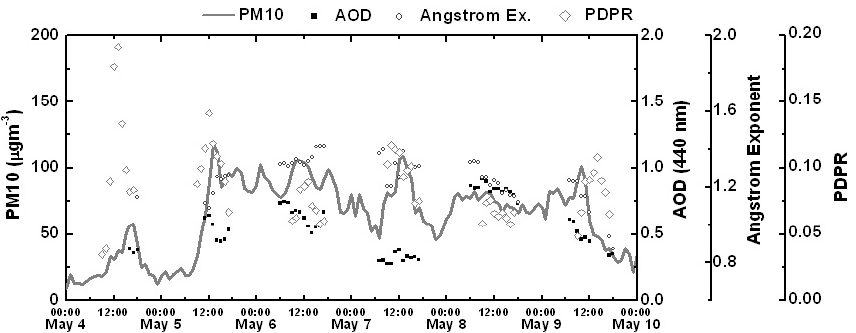
Fig. 4. Hourly averaged PM 10 concentration (solid line) measured from 4–10 May 2009. Also shown are aerosol optical depth at 440nm (dark square) and the ˚Angstr¨om exponent (open circle, wavelength range 440–870nm) measured by the AERONET sun/sky radiometer. PDPR (open diamond) denotes the linear particle depolarization ratio.